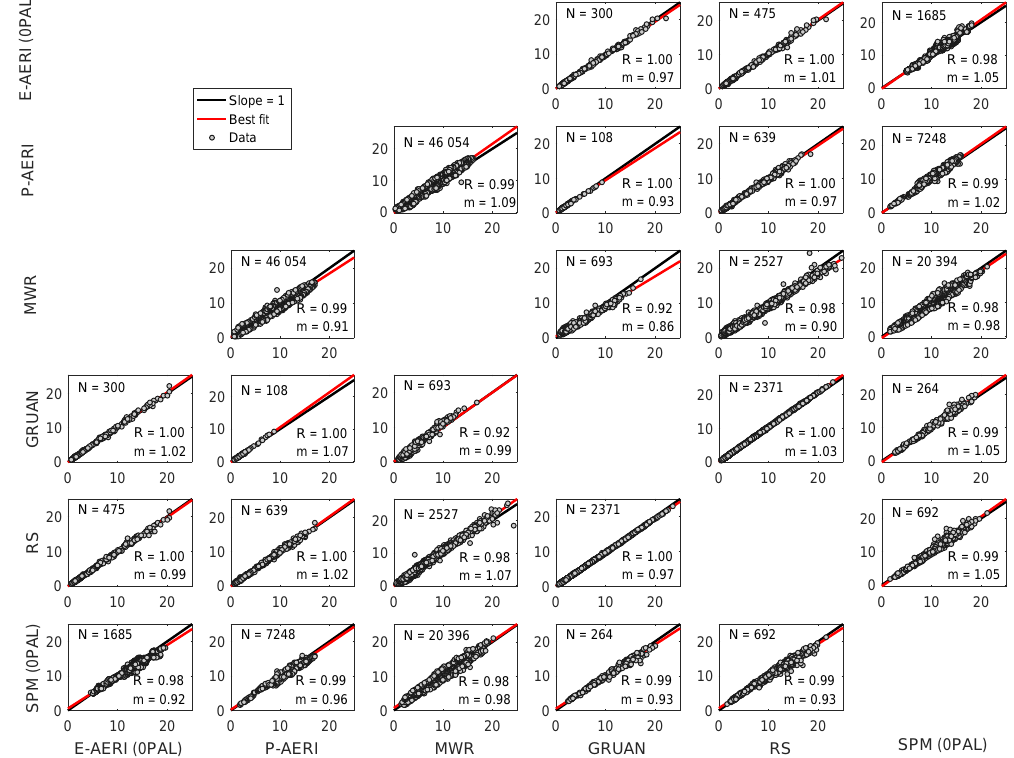
Figure 12. Water vapour total column (mm PWV) correlations between instruments at 0PAL. A high-resolution version of this figure can be found in Fig. S2.